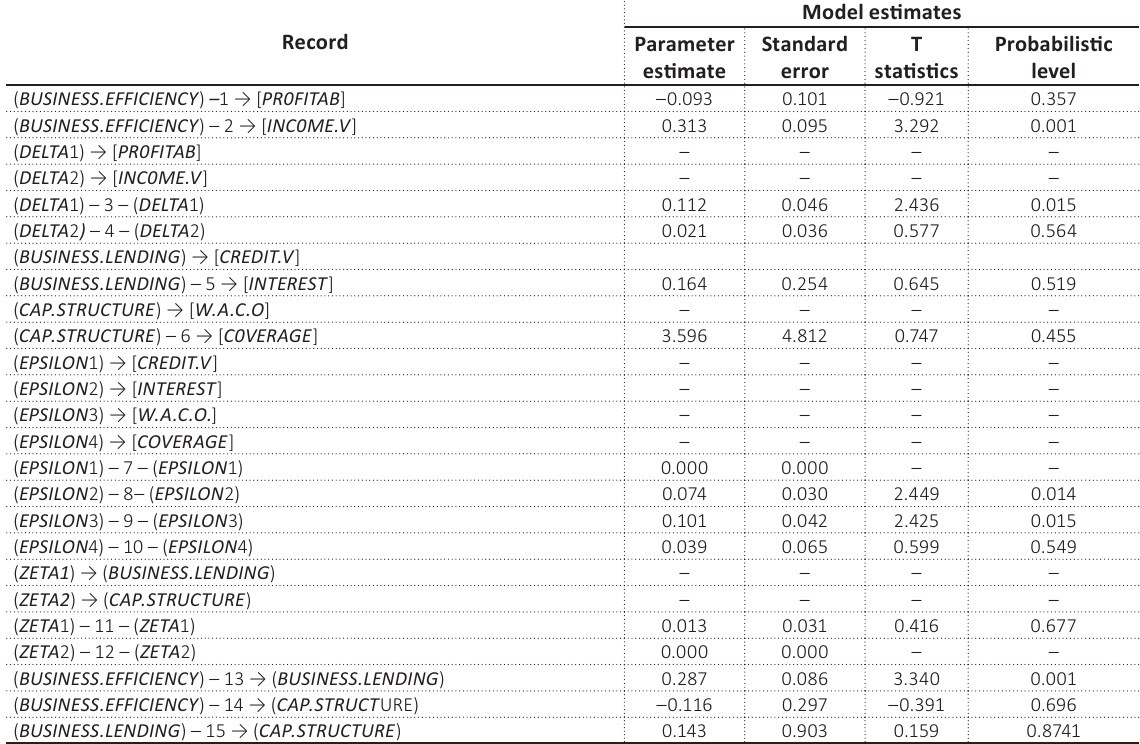
Table 4. Structural equation modeling results of the indicators’ relationship Record